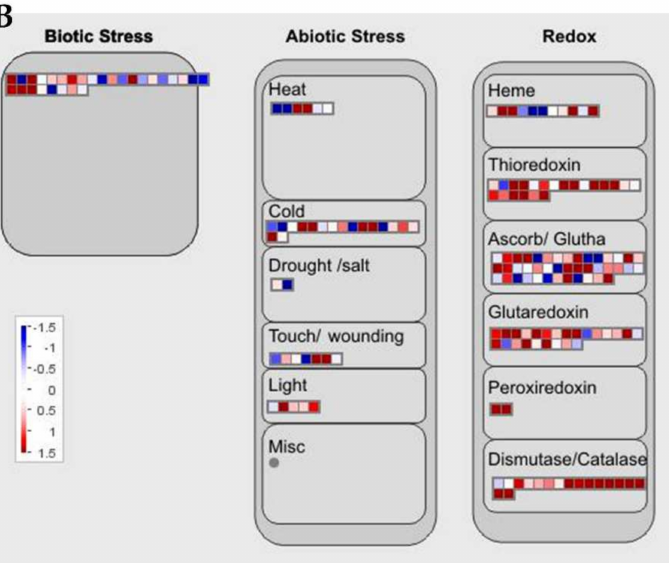
Figure 6. MapMan cellular response overview of the transcriptional regulation between Ilpum and NIL upon GRH infestation. Induction or suppression of the expression of genes involved in different metabolic pathways in ( A ) Ilpum and ( B ) near-isogenic line (NIL) derived from a cross between Ilpum (recurrent parent) and Shingwang (donor parent of Grh1 ), in response to green rice leafhopper (GRH) infestation in rice. Red squares are upregulated genes and blue squares are downregulated genes. Data are logarithm base 2 of fold change (Log 2 FC) (FPKM_value 2/FPKM_value 1). Red boxes are upregulated genes, blue boxes are downregulated genes, and white color indicates Log 2 FC ±